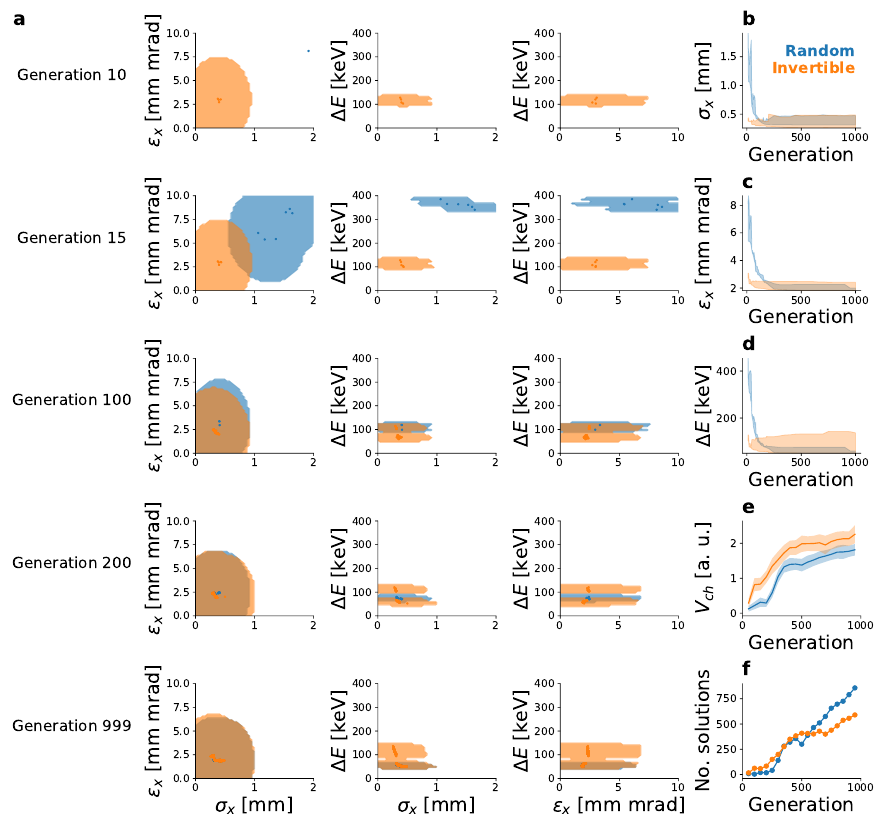
Figure 4. Convergence of the AWA optimisation. The figures show two-dimensional projections of the objective space ( a ), i.e., the quantities of interest at 26m. The shaded area denotes the prediction uncertainty at 90% confidence, and the dots are the predictions themselves. Panels ( b – d ) depict the ranges of objective values among the non-dominated feasible solutions, the volume of the convex hull around the non-dominated solutions plus/minus Monte Carlo uncertainty ( e ) and the number of non-dominated solutions ( f ). The colour blue indicates that the optimiser is initialised randomly, and orange indicates that the invertible model is used for the initialisation. All quantities of interest are calculated using the forward surrogate model.